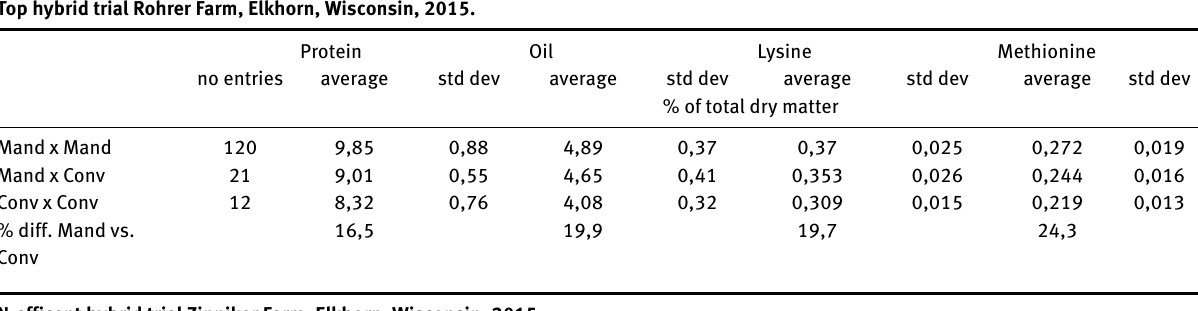
Table 2: Quality results from experiments comparing hybrids made by crossing Mandaamin x Mandaamin inbred, Mandaamin x conventional inbreds, and conventional x conventional inbreds in 2015 Top hybrid trial Rohrer Farm, Elkhorn, Wisconsin,